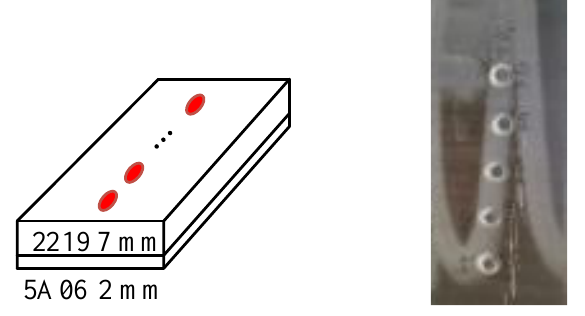
Figure 4. Specimen size and spacing working conditions.